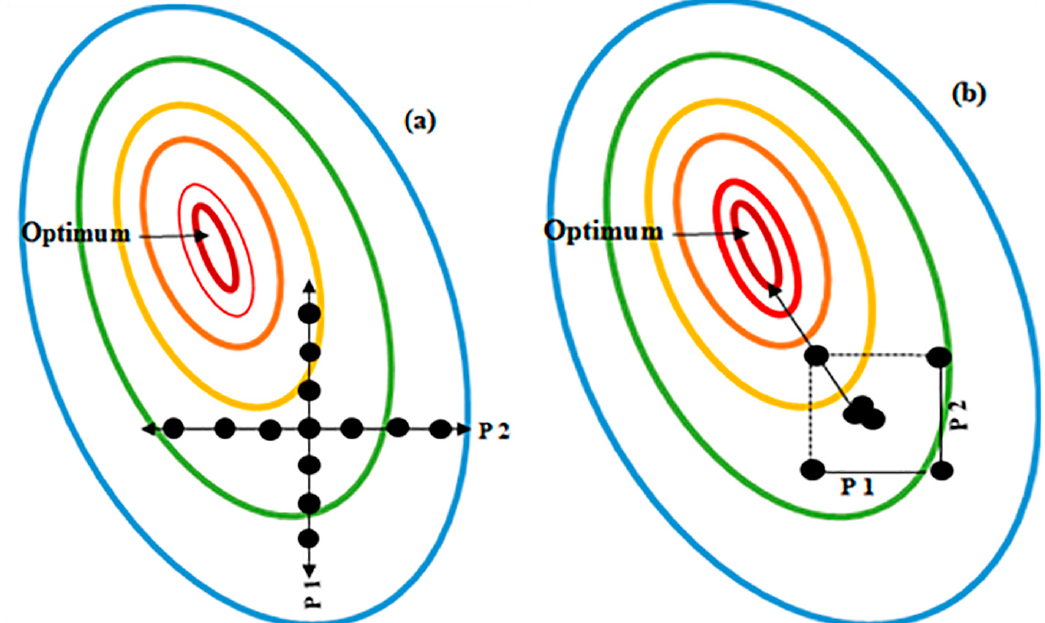
Figure 2 . Comparison between Design of Experiments (DoE) and One-Factor-at-A-Time (OFAT) by examining the effect of two parameters, P1 (Parameter 1) and P2 (Parameter 2). ( a ) OFAT is performed using more experiments than DoE (each black dot represents an experiment) and does not identify the true optimum (indicated as a red oval). However, with the DoE approach ( b ) fewer experiments are used and the likelihood of finding the optimum conditions (in red) for the process being studied is high. With DoE the combined or interaction effect of P1 and P2 on the response can be identified and measured. The ovals indicate production yields, blue indicates the lowest yields, whereas red indicates highest yields, where the optimum is found. The DoE approach also identifies a pathway to the optimum response (indicated by the arrow).